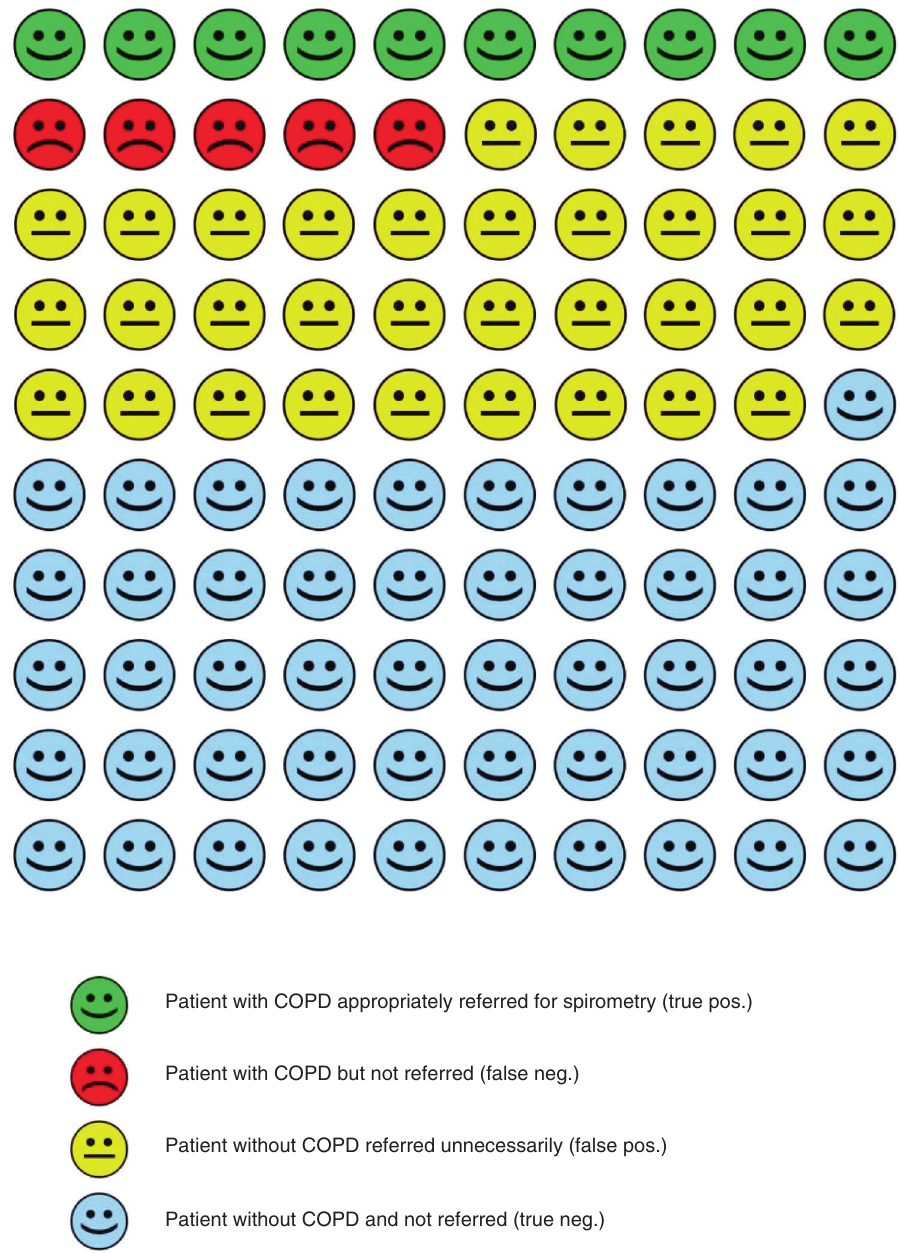
Fig. 2 Diagnostic accuracy of the SCSQ in a hypothetical sample of 100 participants, 15 of whom have undiagnosed